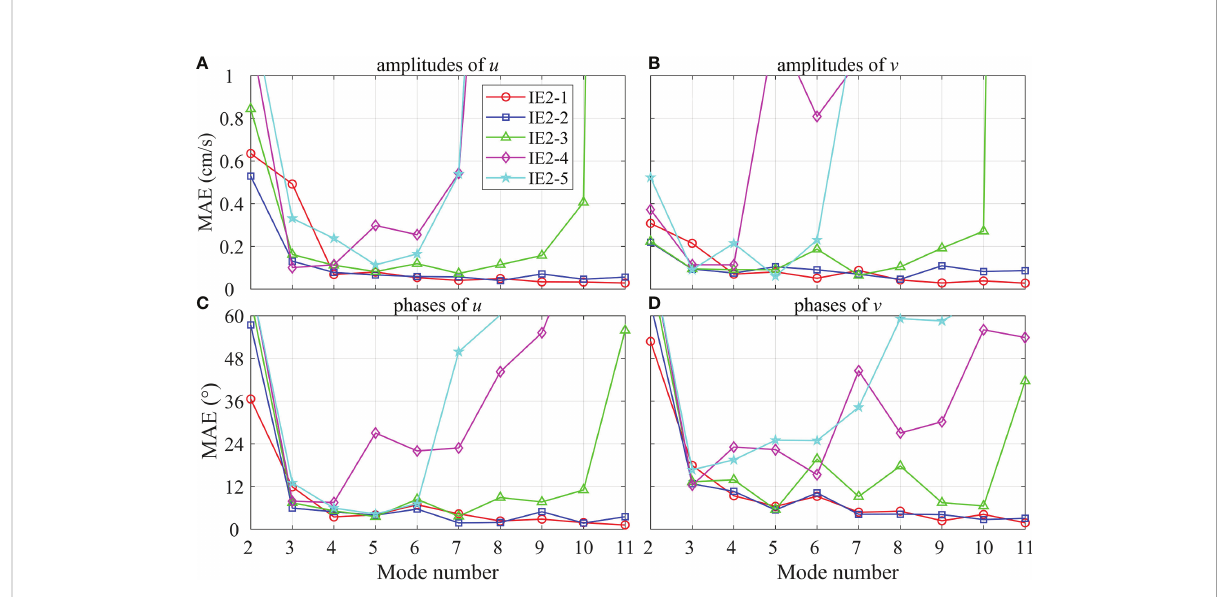
FIGURE 10 The MAEs of amplitudes of (A) u and (B) v from IE2-1 to IE2-5 at the mooring MP3 with different mode number, and the MAEs of phases of (C) u and (D) v from IE2-1 to IE2-5 at the mooring MP3 with different mode